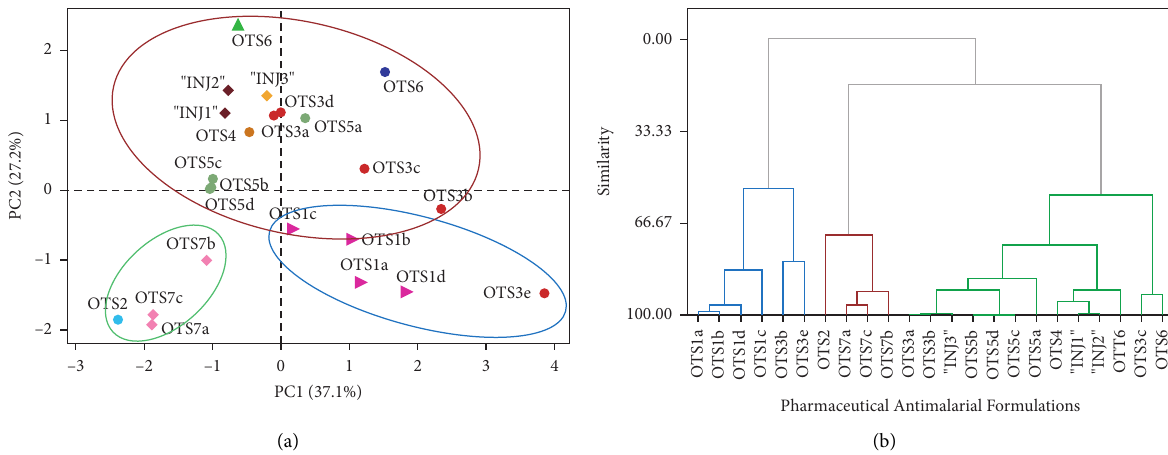
Figure 4: Multivariate data analysis of analytes contents in the quinine-based pharmaceutical antimalarial formulations. (a) Score plot from the principal component analysis showing some similarities and dissimilarities among the investigated products. Products with the same color symbols originate from the same manufacturer. (b) Dendrogram from hierarchical cluster analysis showing the clustering of the samples as determined from the contents of quinine and its related alkaloidal substances in the